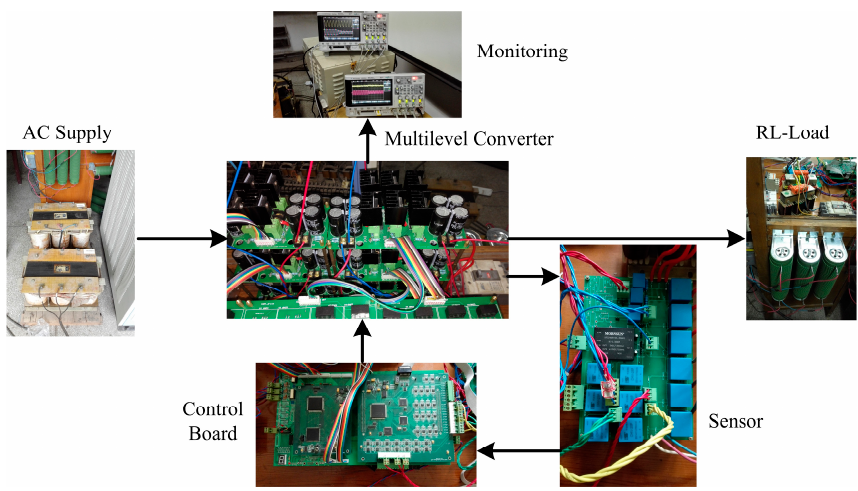
Figure 10. Experimental setup for the proposed multilevel converter. Table 6. Parameter settings for simulation and experiment.